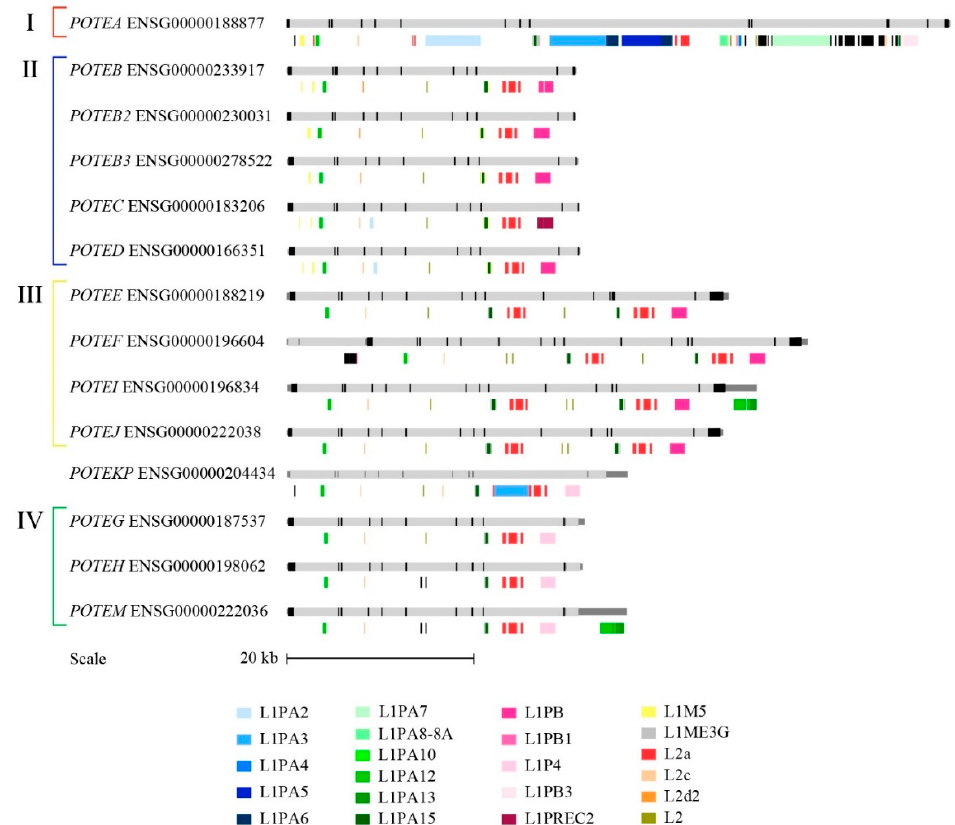
Figure 4. LINE contents of the 14 human POTE genes are displayed under each gene representation. The LINEs annotated as black blocks represent less frequent elements, thus not explained in the color legend at the bottom of the figure.